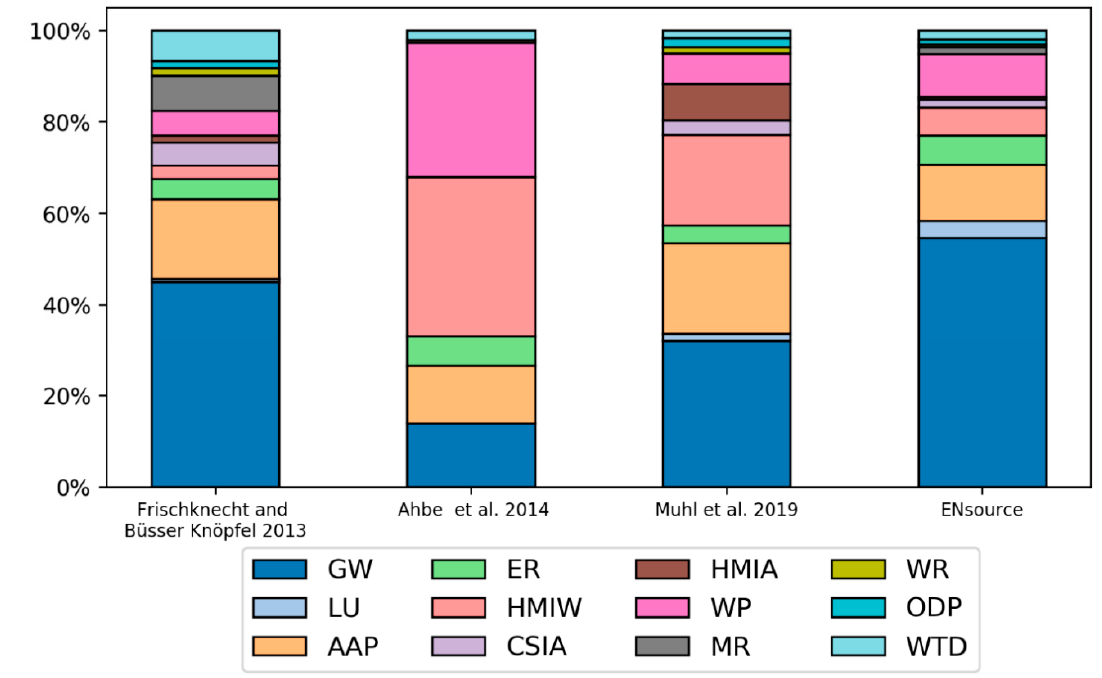
Figure 1. Weighting schemes of the different ecological scarcity methods. GW = global warming, LU = land use, APP = main air pollutants and PM, ER = energy resources, HMIW = heavy metals into water, CSIA = carcinogenic substances into air, HMIA = heavy metals into air, WP = water pollutants, MR = mineral resources, WR = water resources, ODP = ozone layer depletion, WTD = non-radioactive waste to deposit.